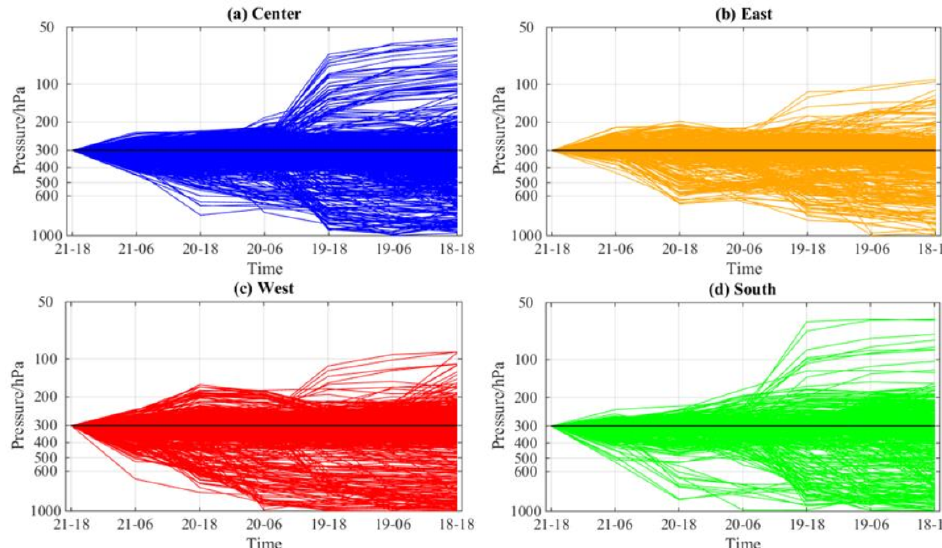
Figure 6. The 3-day backward trajectory of the height of air parcels at the center ( a ), east ( b ), west ( c ), and south ( d ) sides of the COL at 300